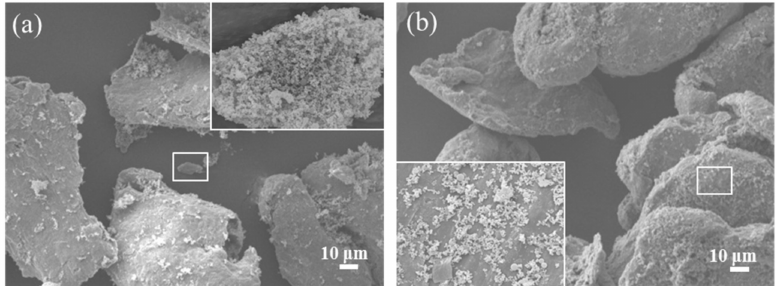
Figure 3. FESEM images of the samples by di ff erent decentralized processing: ( a ) PCNS / Mg, ( b ) PCNS@PVP /